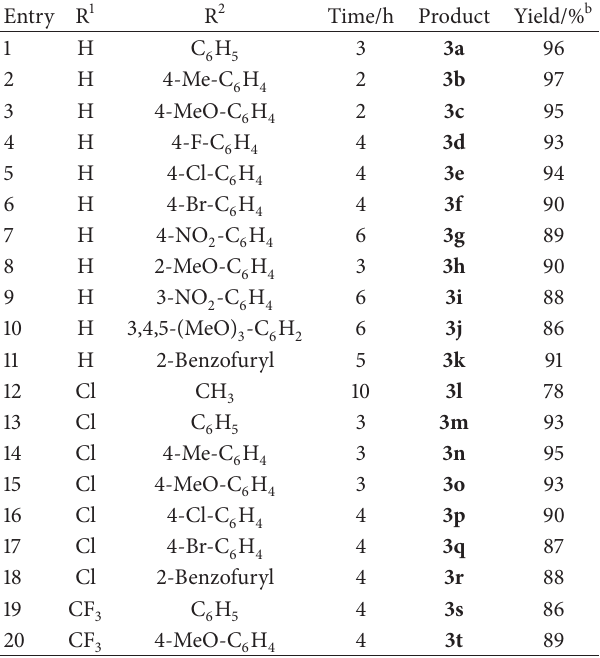
Table 2: Solvent optimization for the synthesis of 3-phenyl-2 H -1,4- benzothiazine a .